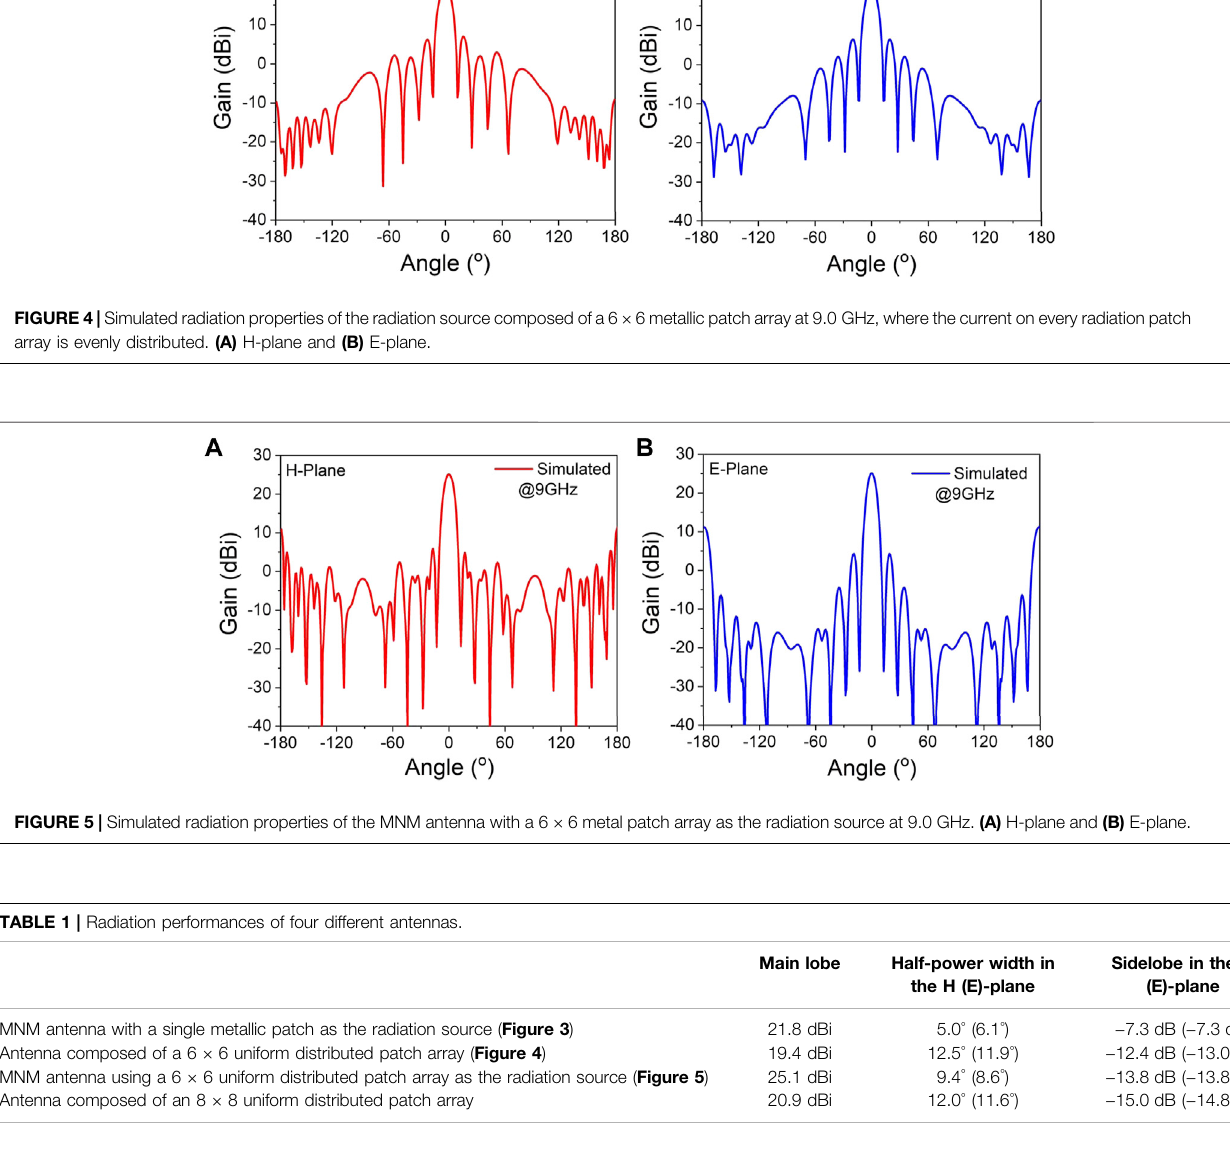
performance of the MNM antenna with a 6 × 6 metallic patch array as the radiation source at 9.0 GHz is given in Figure 5 . The gain of the main lobe is 25.1 dBi, and the half-power width is 9.4 ° (8.6 ° ), but the sidelobe level is − 13.8 dB ( − 13.8 dB) in the H (E)-